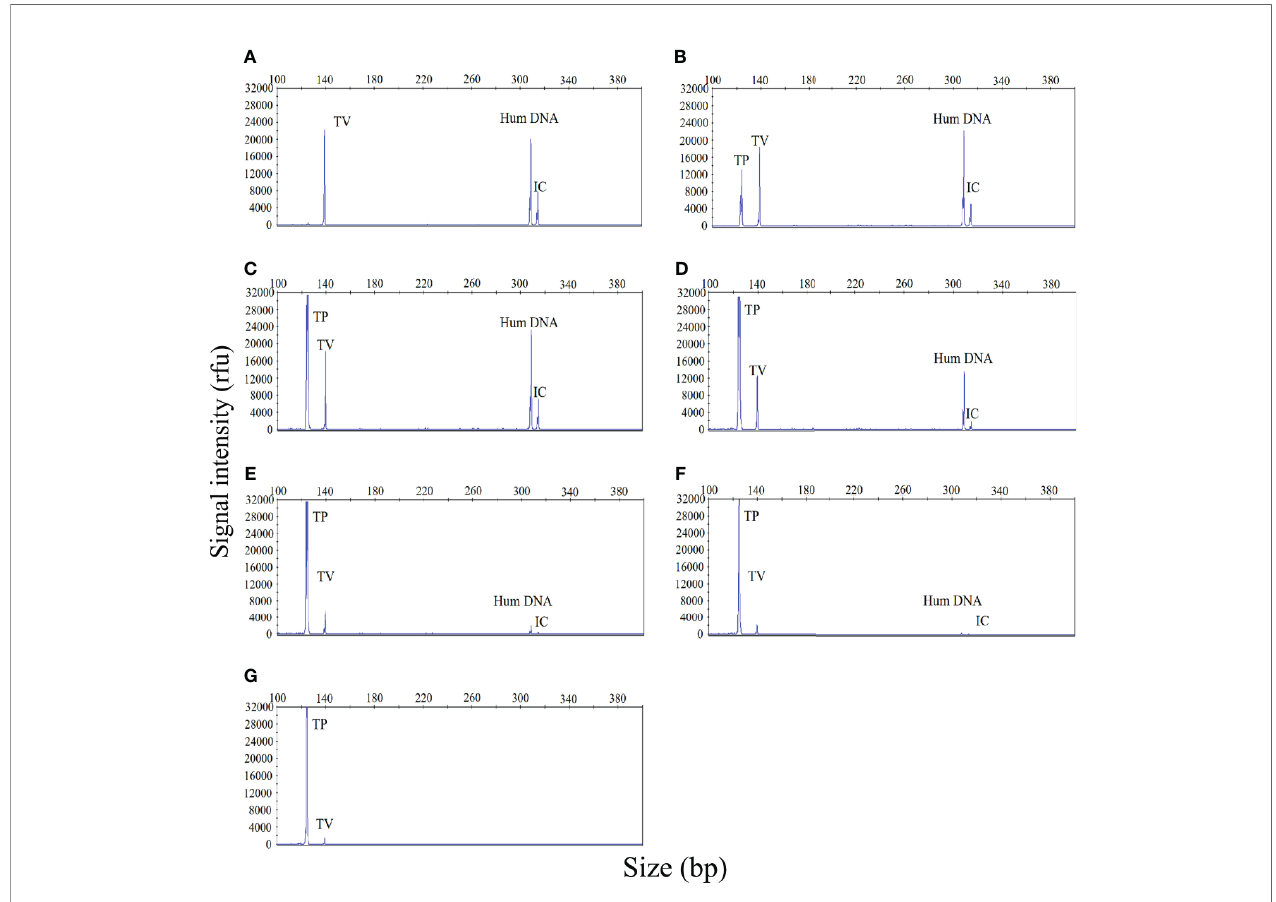
FIGURE 3 | The sexually transmitted infection high-throughput multiplex gene detection system (STI-HMGS) assay accurately detected an individual pathogen in a mixture containing two DNA templates without interference from a dominant template over a large range of concentrations. (A) The Trichomonas vaginalis (TV) plasmid produced a signal intensity of 2200rfu. (B – G) Within the mixture of DNA templates, we increased the concentration of the Treponema pallidum (TP) plasmid from 10 1 , 10 2 , 10 3 , 10 4 , 10 5 to 10 6 copies/µL in a sequential manner while maintaining the concentration of the TV plasmid at 10 copies/µL throughout. The signal intensity for the TV plasmid showed progressive weakening from 20000, 18000, 12000, 6000, 2000, to 1000rfu. The two control genes were maintained at the same concentrations at all times; the signal intensity for these genes also showed a gradual